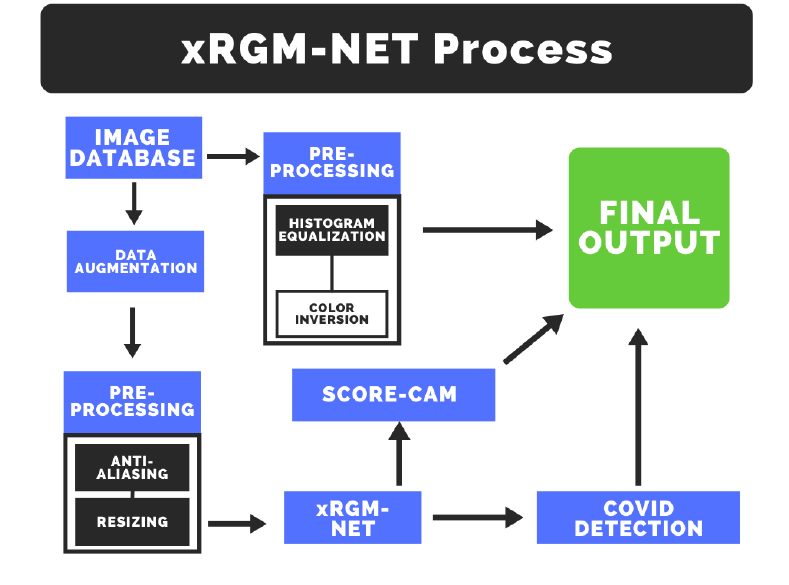
Figure 2. xRGM-NET